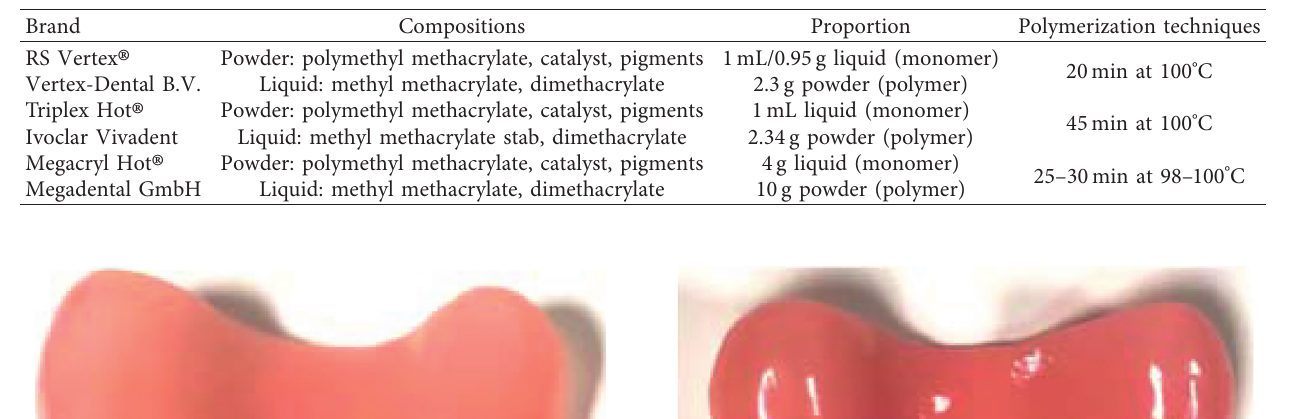
Table 1: Acrylic resin characteristics.